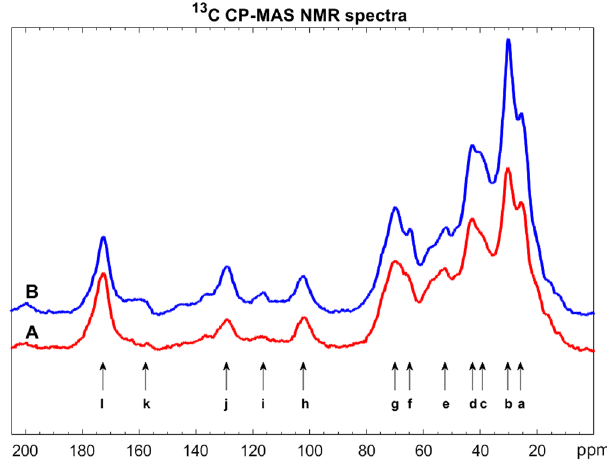
Figure 5. 13 C CP-MAS NMR spectra of sunflower (mark A, red curve) and rape (mark B, blue curve) sporopollenins treated by the enzyme cocktail. The integral intesities of i, j, k aromatic carbon signals of p-coumaric groups and e, f, g O-aliphatic peaks were compared to each other.